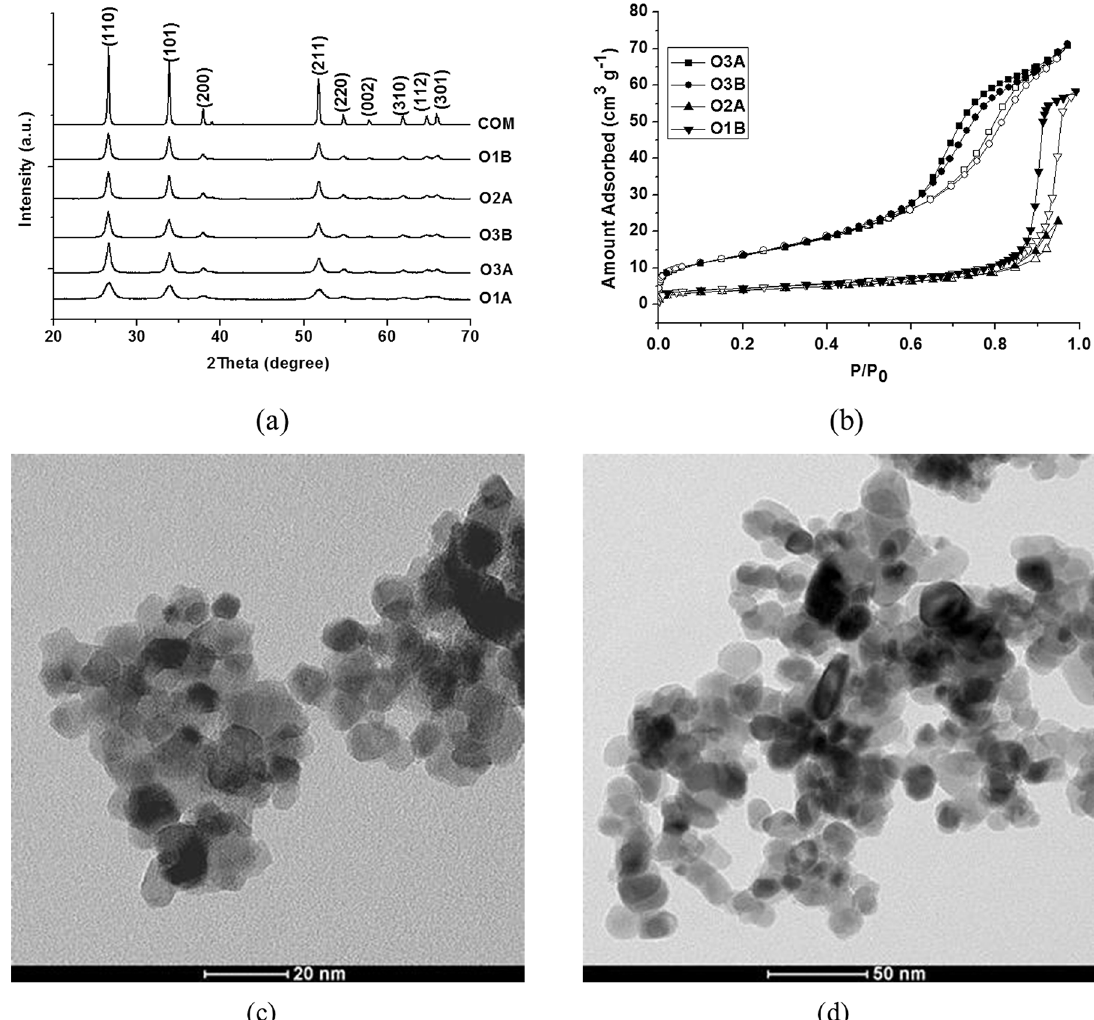
samples synthesized using different processes and calcinations temperatures, Figure 3. Characterization of commercial oxide and SnO 2 for: a) XRD patterns, b) Nitrogen adsorption-desorption isotherms,c) TEM images of O1A and d) TEM images of O3B. Table 2. Chemical, textural and morphological characterization and band gap of SnO2 for different synthesis methods and temperatures.